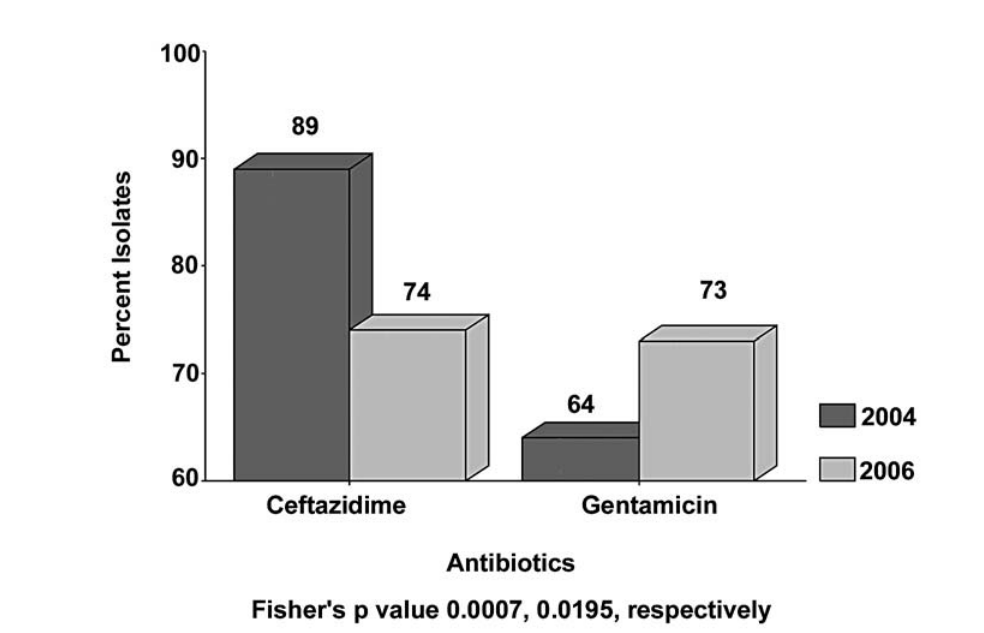
Figure 2 – Altered susceptibility